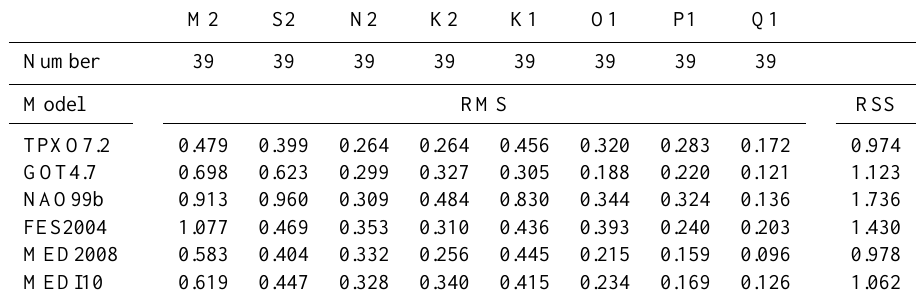
Table 12. RMS and RSS of the differences between the constituents of the empirical model EOT10a at crossovers over Mediterranean, and other contemporary global and regional tide models. Unit iscm.